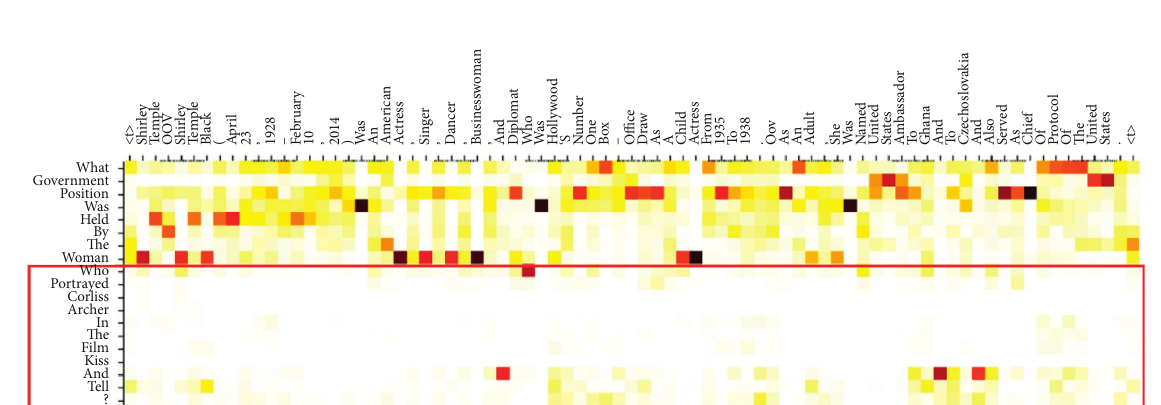
Figure 3: Attention heat map of the only-ans model.